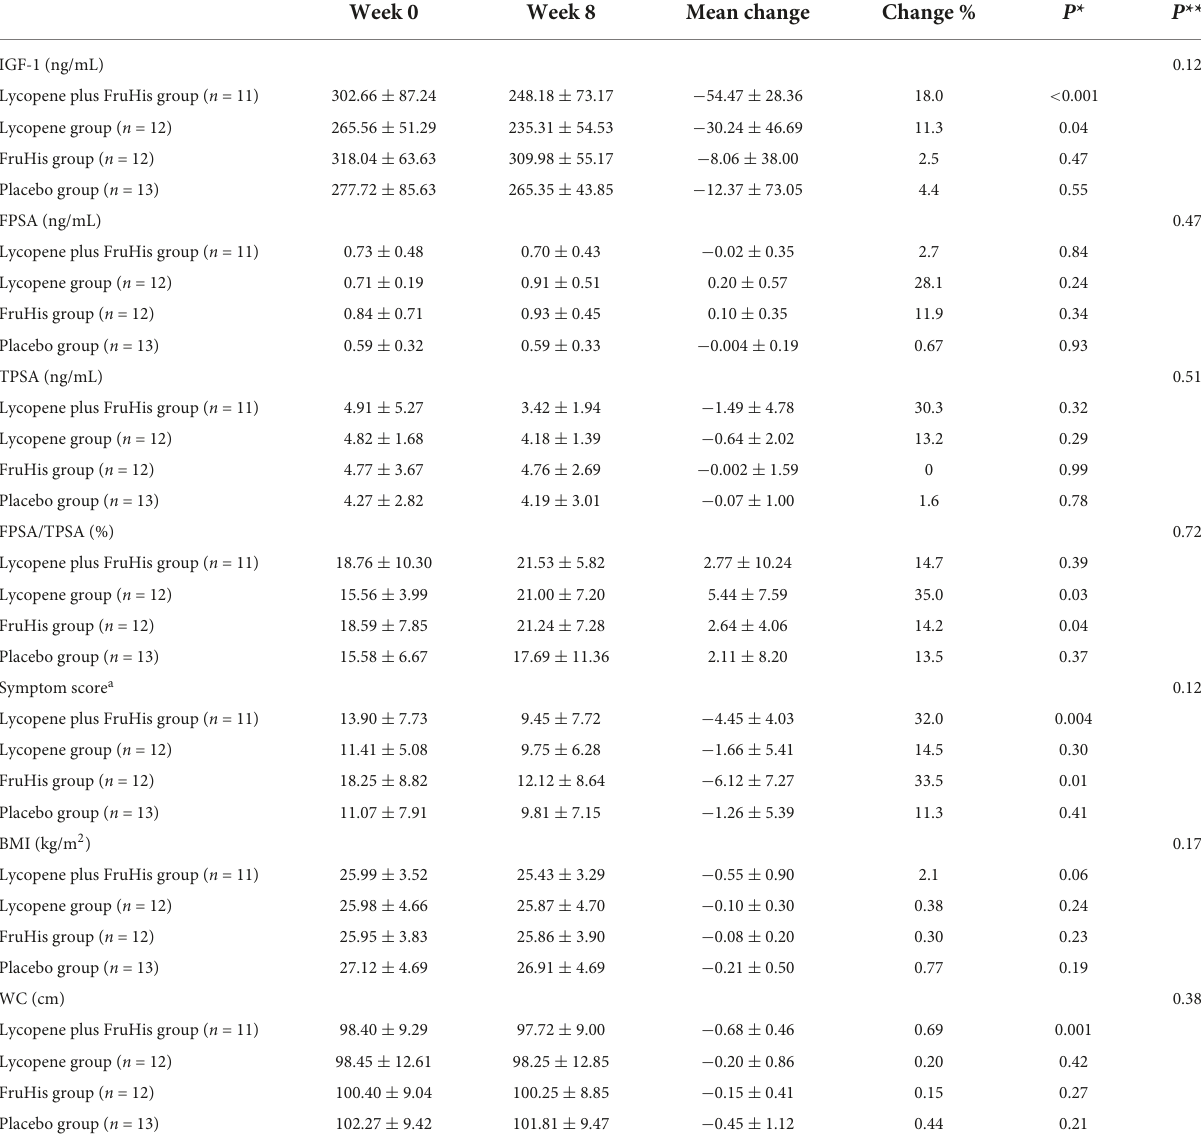
TABLE 3 Means of outcome variables at baseline and end of the trial and changes during the trial in the intervention